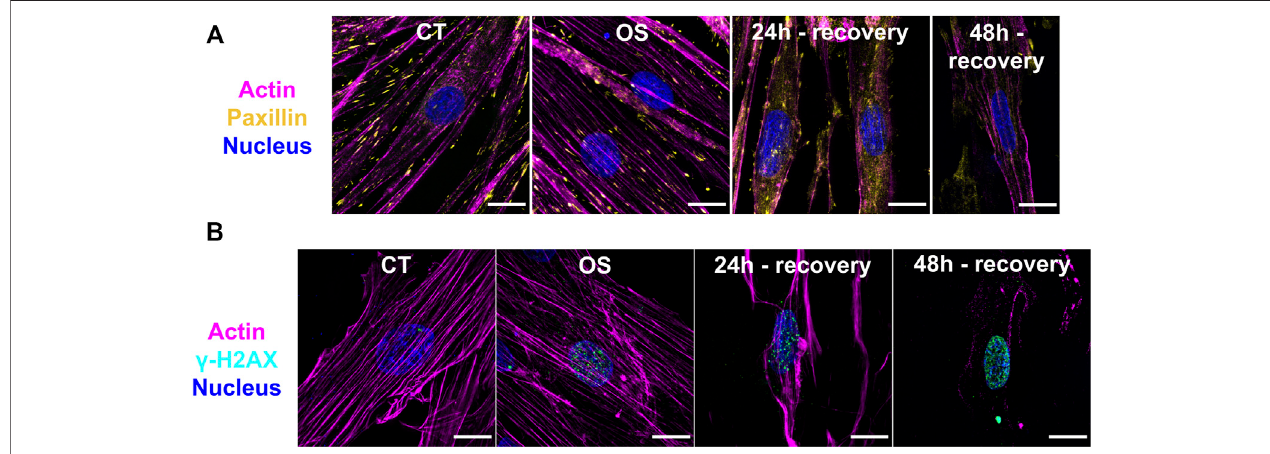
FIGURE 1 | Immuno fl uorescence images from H9c2 cardiomyocytes after oxidative stress and different recovery times. (A,B) SR-SIM microscopy of cardiomyocytes from Control (CT), oxidative stress (OS), and 24- and 48-h recovery groups. Magenta: actin; Yellow: paxillin; Cyan: γ H2Ax; Blue: nucleus. Scale bar = 15